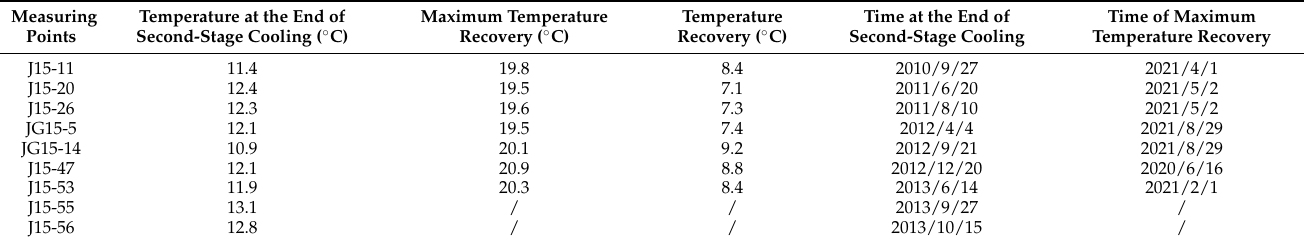
Table 3. Statistics of temperature recovery at measuring points of arch dam internal joint